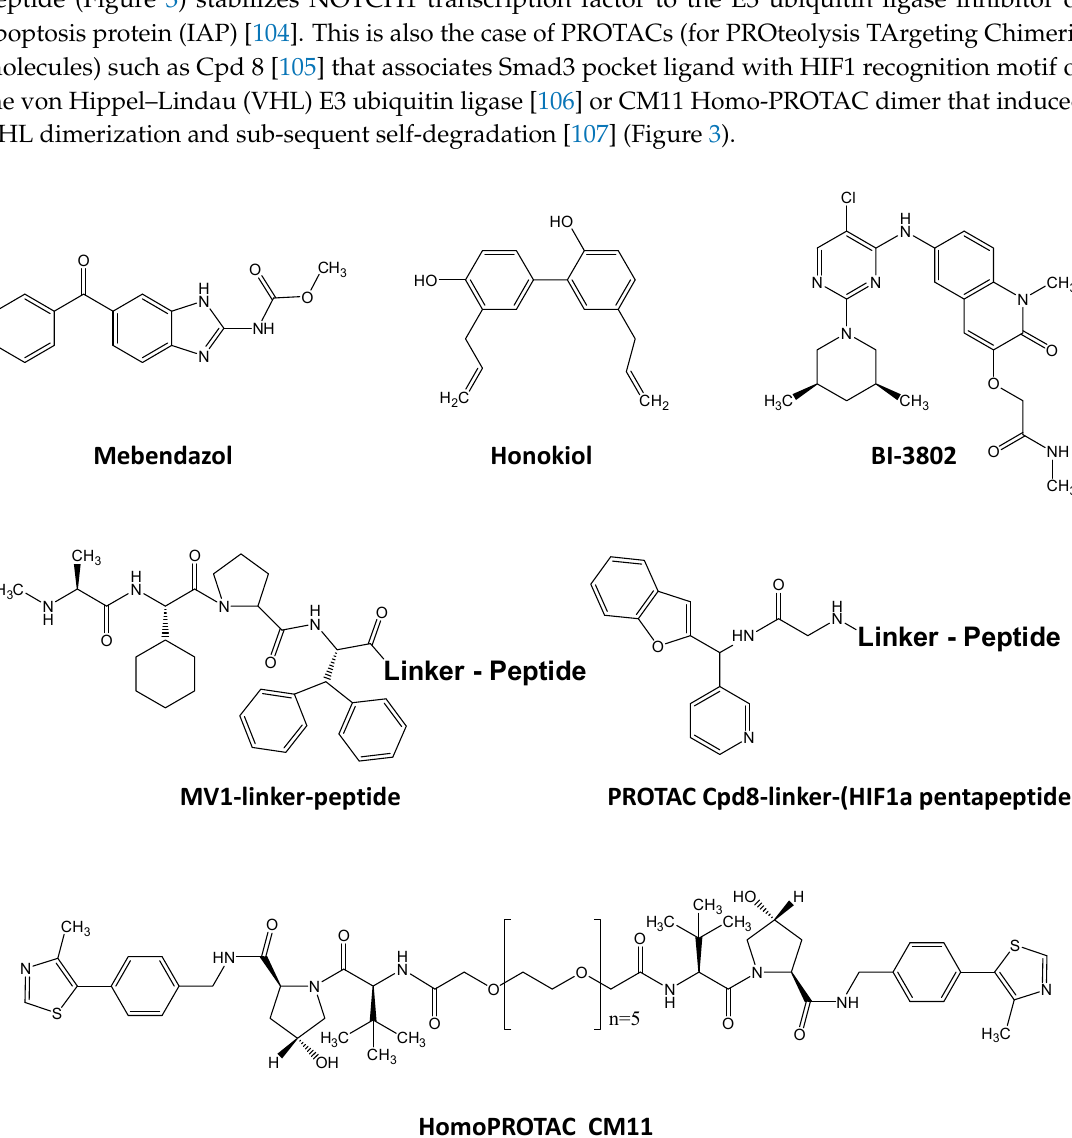
Figure 3. Small compounds ( Top ) or drug-linker peptides ( Middle and Bottom ) inducing degradation of oncogenic transcription factors.